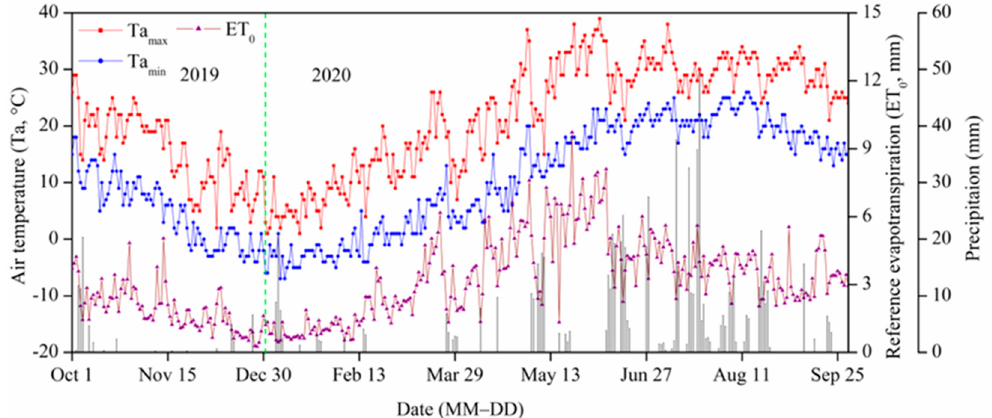
Figure 2. Maximum and minimum air temperature, reference evapotranspiration, and precipitation at the Xuchang Irrigation Experiment Station in the 2019–2020 growing season.